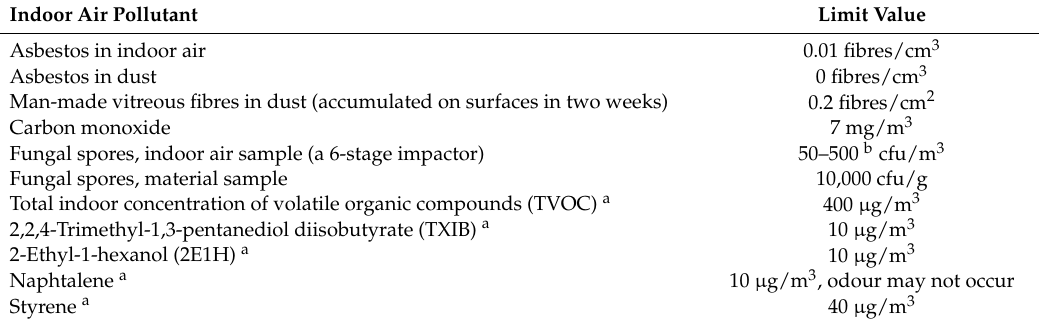
Table 4. National maximum limit values for IA concentrations, microbial growth on building material and MMVF and asbestos in dust. Evaluation of abnormal indoor microbial sources also includes the identification of micro-organisms (genus/species/groups). With regard to the air sample (microbial), there shall also be other evidence of exceeding the limit value in addition of IA microbial concentration. The limit value for the total indoor concentration of a single organic compound determined as toluene equivalent is 50 µ g/m 3 , exceptions are presented in this table [44]. Measurements and sampling methods are shown in the Section